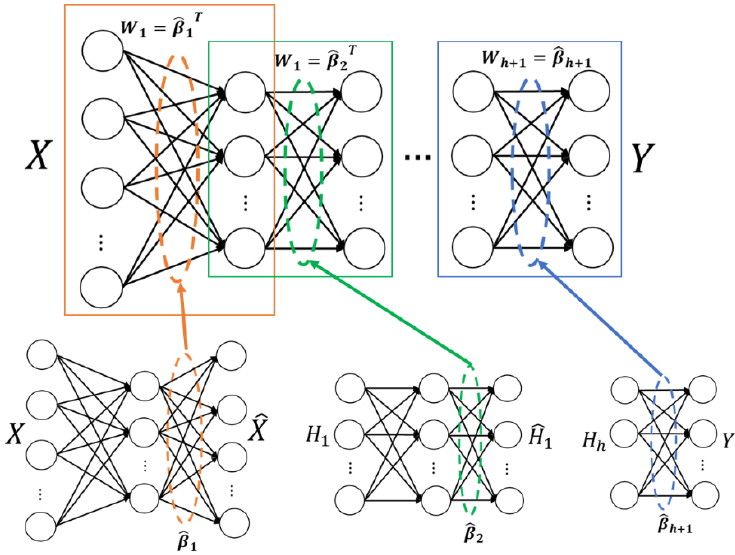
Figure 2. Deep extreme learning machine (DELM) network structure diagram.